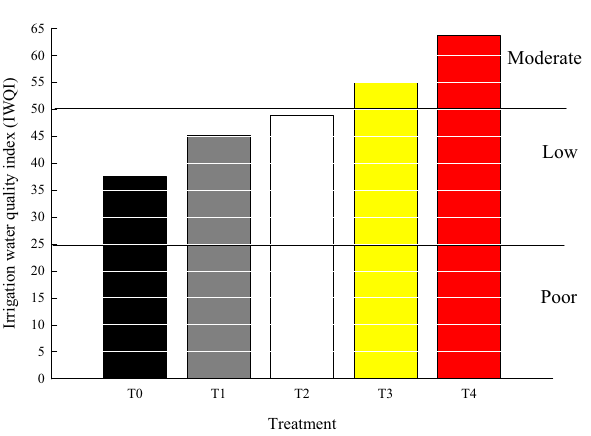
Figure 6. Irrigation water quality index calculated for wastewater collected from each treatment unit. T 0 (untreated water), T1 (water after sedimentation unit), T 2 (water after sand & gravel beds), T 3 (water after reed + sand & gravel beds) and T 4 (water after biochar + sand & gravel beds). Similar letters indicate no significant variations among